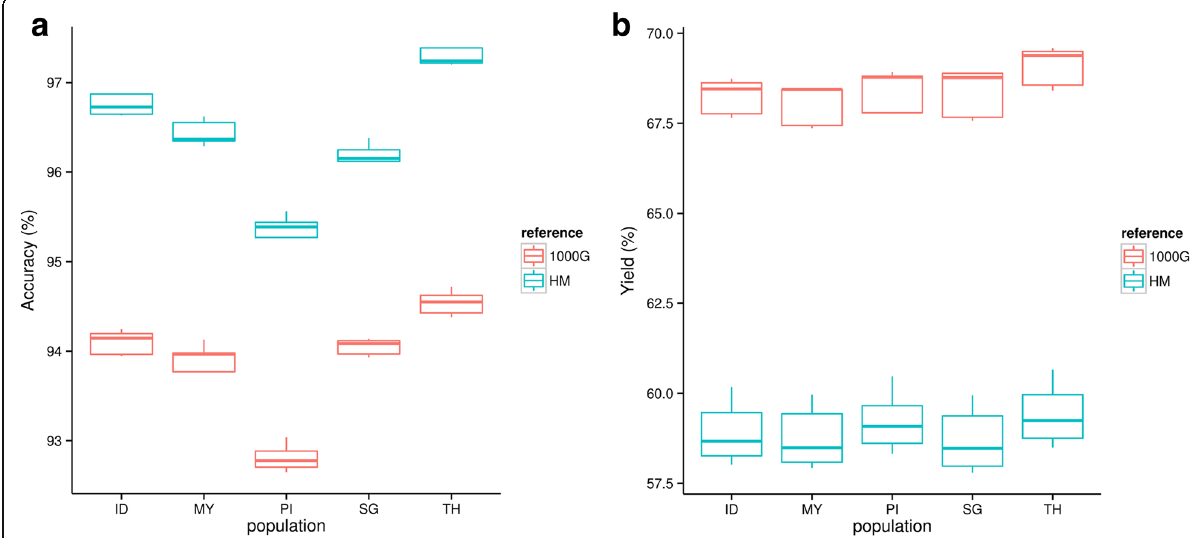
Fig. 1 Boxplot of accuracies and yields for imputation results across all populations. Five percent of randomly removed SNPs were imputed with IMPUTE2 using either the 1000 Genomes project phase I (1000G) or combined Chinese and Japanese haplotypes from the International HapMap project phase II (HMII) as a reference. The imputed SNPs were tested for accuracy with the previously removed SNPs. The same set of the removed SNPs was applied to all population dataset. The technique was repeated five times. a Boxplot of accuracy comparing populations and references. b Boxplot of yield comparing populations and references. Abbreviations: Indonesia (ID), Malaysia (MY), the Philippines (PI), Singapore (SG), and Thailand